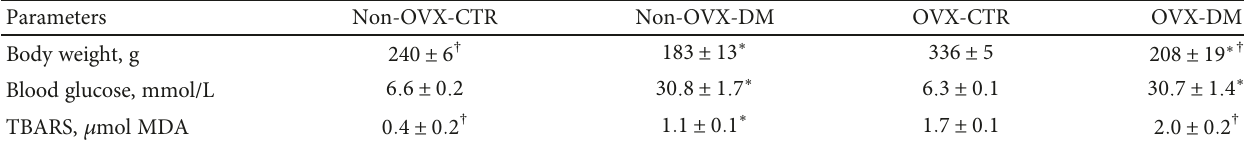
Table 1: Body weight, blood glucose, and oxidative stress level of experimental animals (at the age of 12 weeks). Parameters